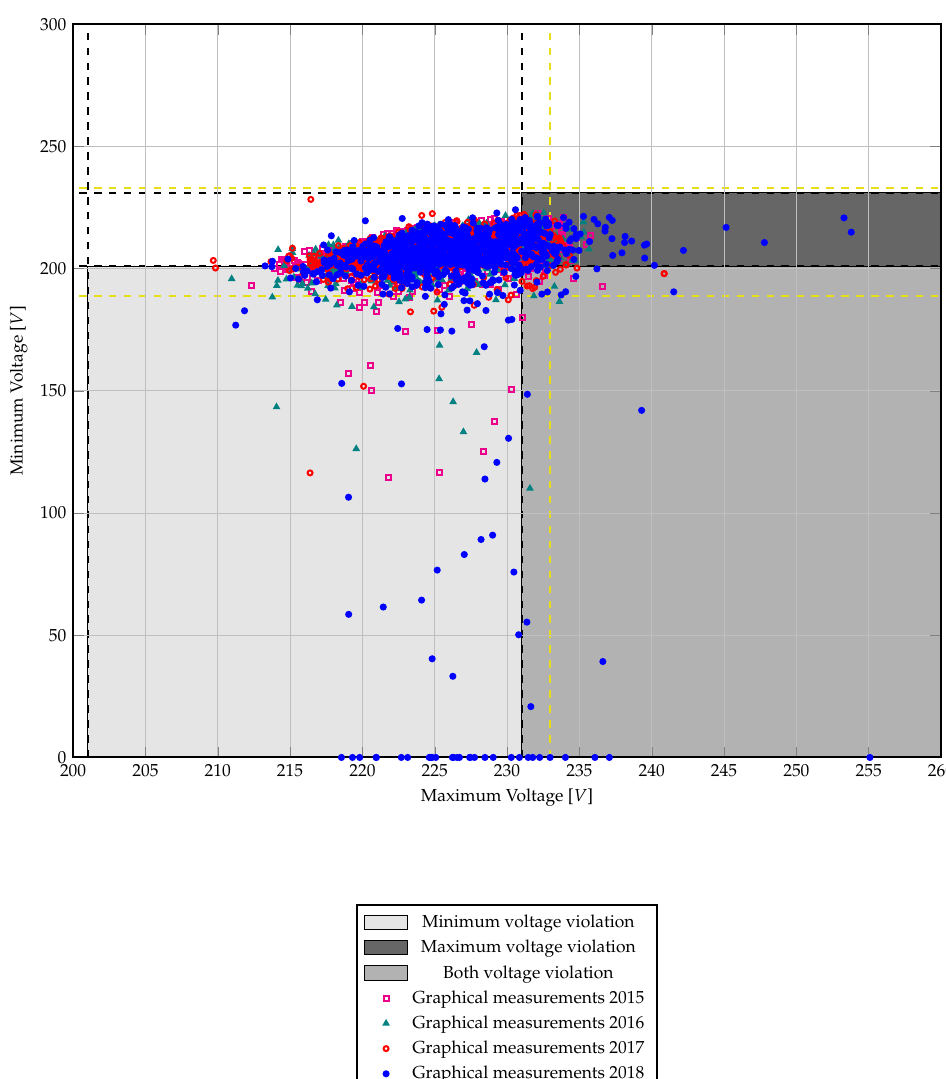
Figure 2. Sample Campaigns carried out by ENEL Distribution S.A. from 2015 to 2018.